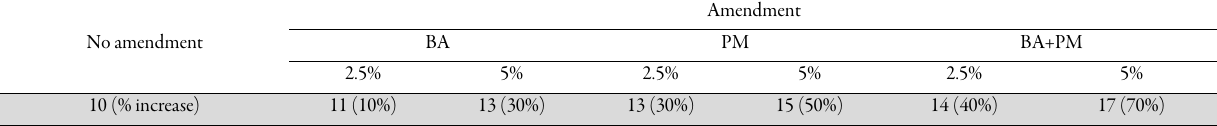
Table 6a. Colonization by P. indica of cucumber roots of 28 day-old plants grown in autoclaved soil without or with amendments. The table shows the number of colonized plants determined by light microscopy (n=20)